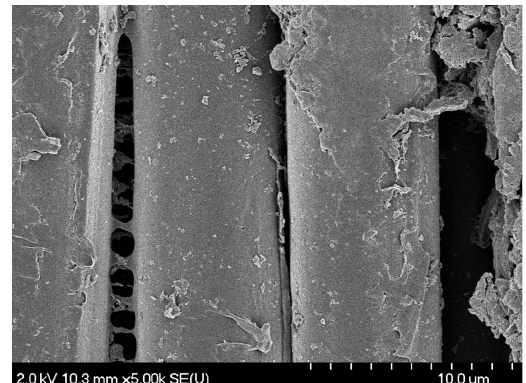
Figure 14: Comparison between autoclave-treated sample (right photo) and non-autoclave-treated sample (left photo) taken from truncated cone # 2.